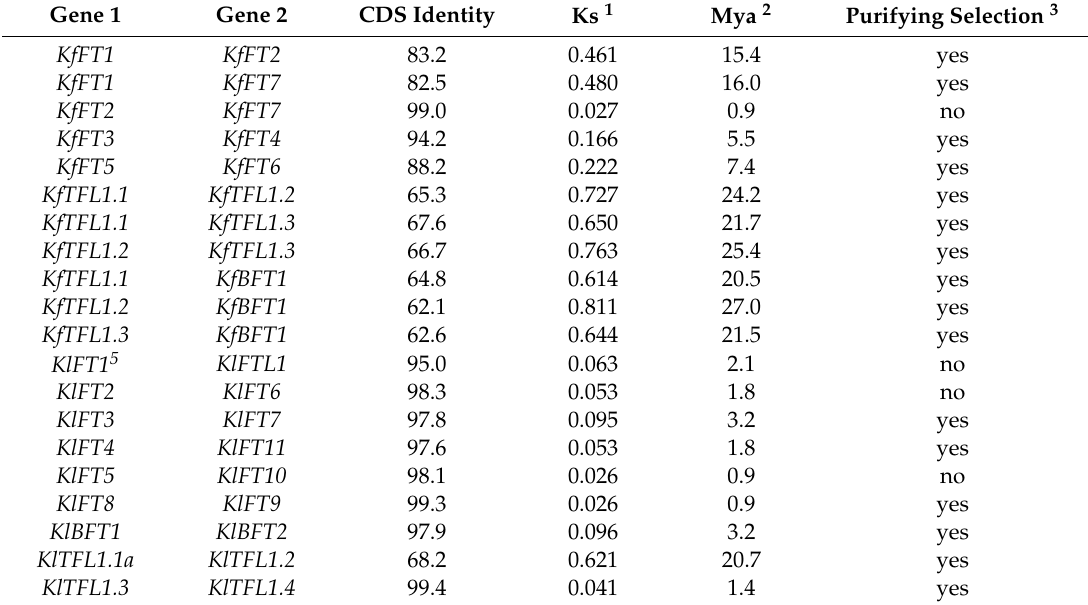
Table 2. The Ks values and estimated absolute dates for the duplication events between the duplicated Kalanchoë genes associated with terminal branches in the tree species clades.